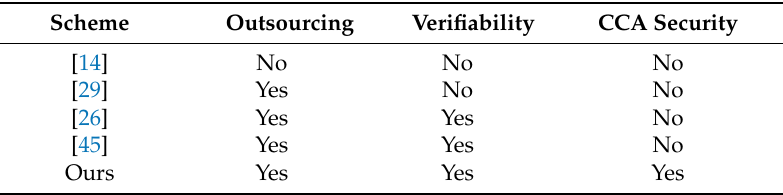
Table 1. Comparisons of